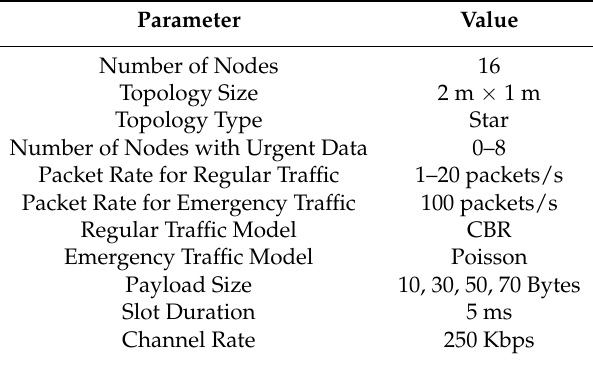
Table 1. SIMULATION